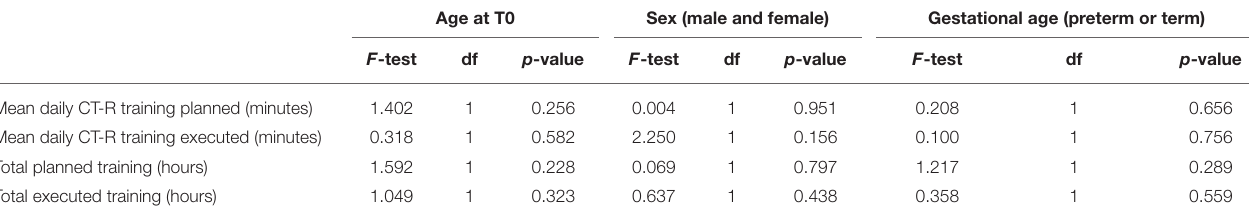
TABLE 4 | Infants characteristics and training.